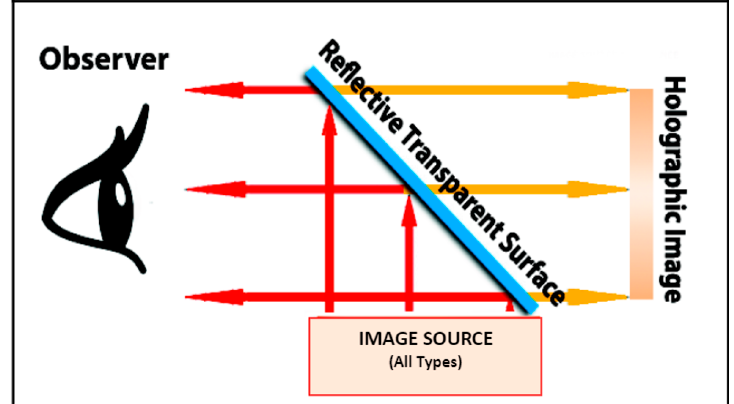
Figure 7. The reflective ray principle of the hologram.